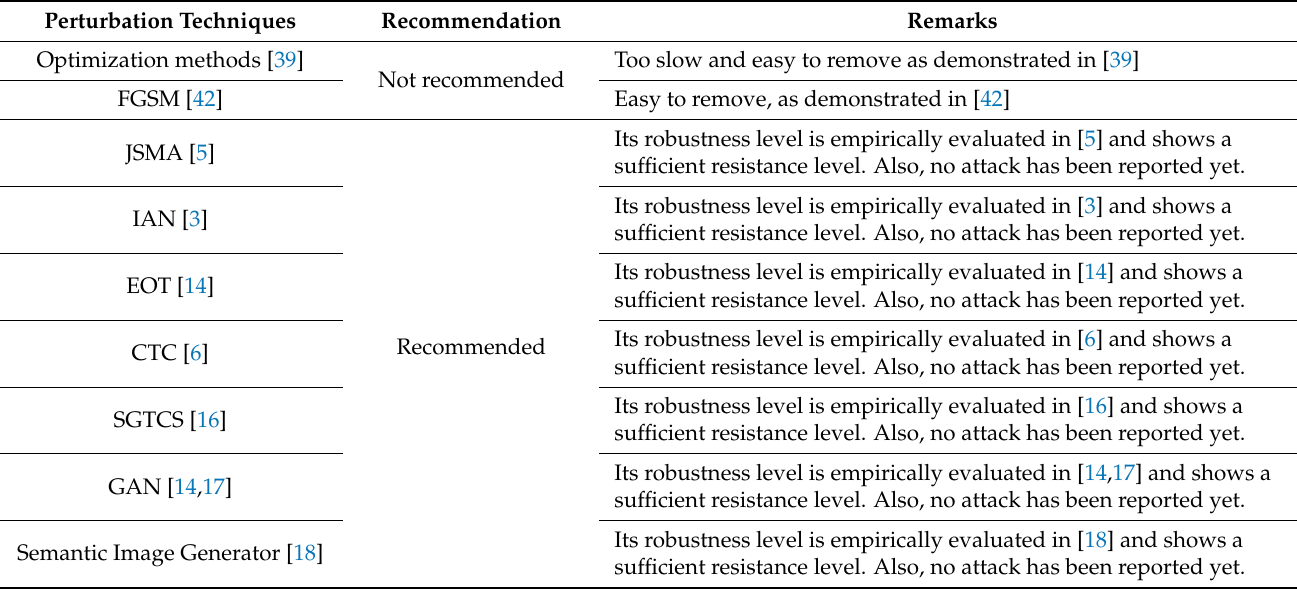
Table 7. Recommended and not recommended perturbation